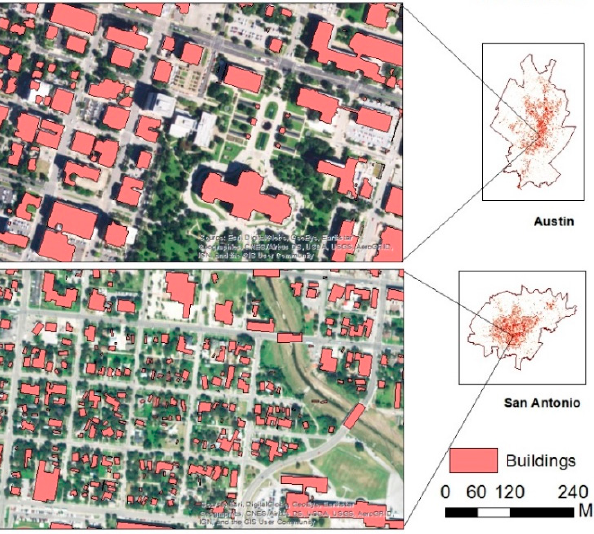
Figure 3. Detailed illustrations ( left ) of building extractions from a selected part ( right ) of the study areas.